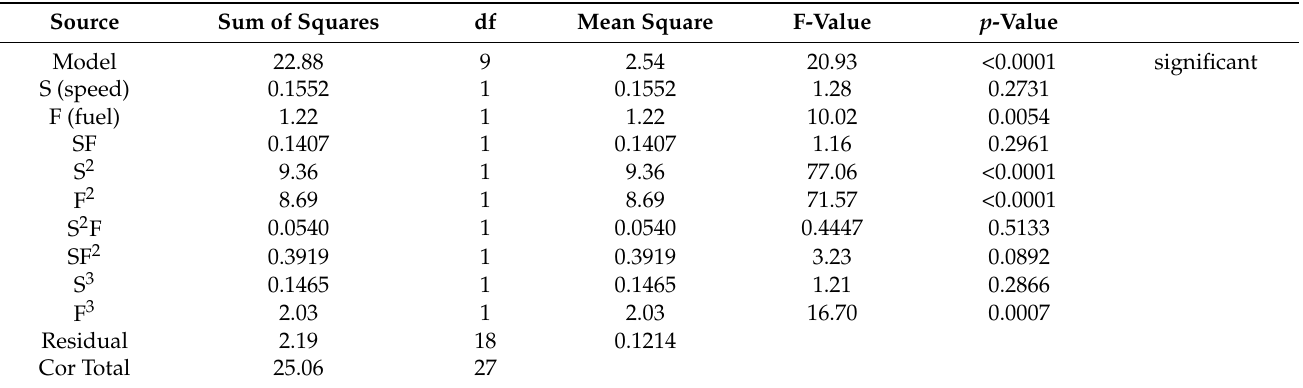
Table 8. ANOVA table for first output response (BT).